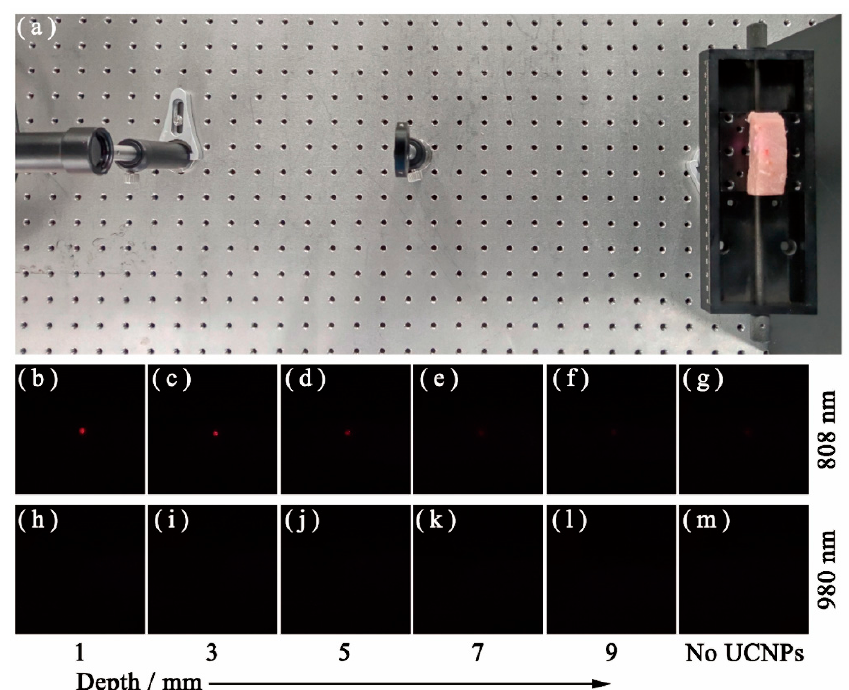
Figure 9. The UC luminescence image of the different depths of pork tissue injected with Y 2 O 3 :Er 3+ /Tm 3+ (8/1 mol%) UCNPs under the excitation of both 808 and 980 nm laser. ( a ) Experiment setup of the ex vivo imaging experiment. The pork injected with ( b – f ) and without ( g ) UCNPs under the excitation of 808 nm laser, respectively. The pork injected with ( h – l ) and without ( m ) UCNPs under the excitation of a 980 nm laser, respectively.